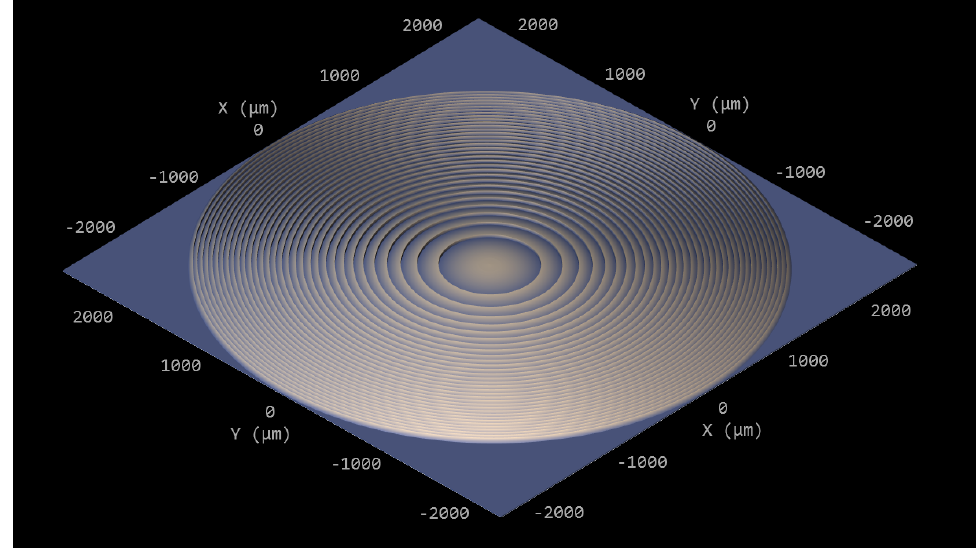
Figure 2. The printed Fresnel lens depicted with the preprint tool